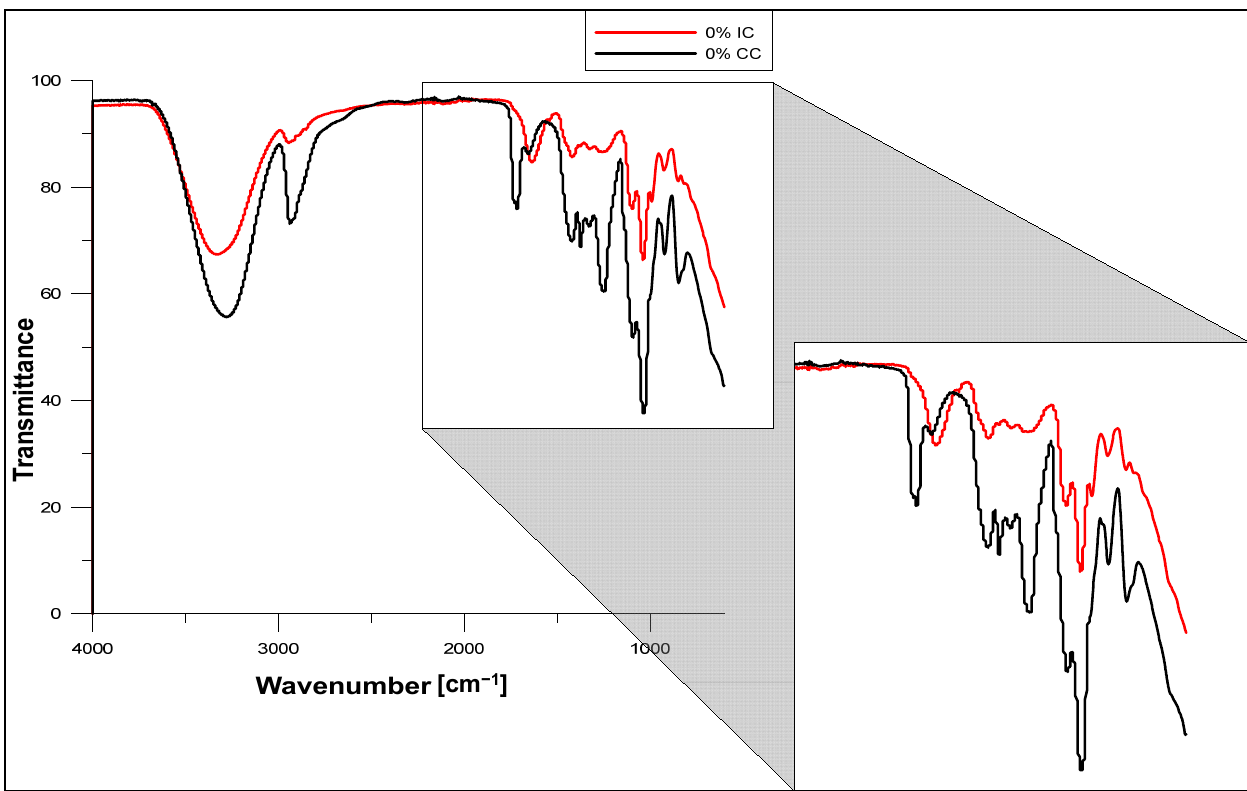
Figure 5. FT-IR spectra of SA/PVA hydrogels prepared using method I (ionic crosslinking, IC) or method II (chemical crosslinking, CC).